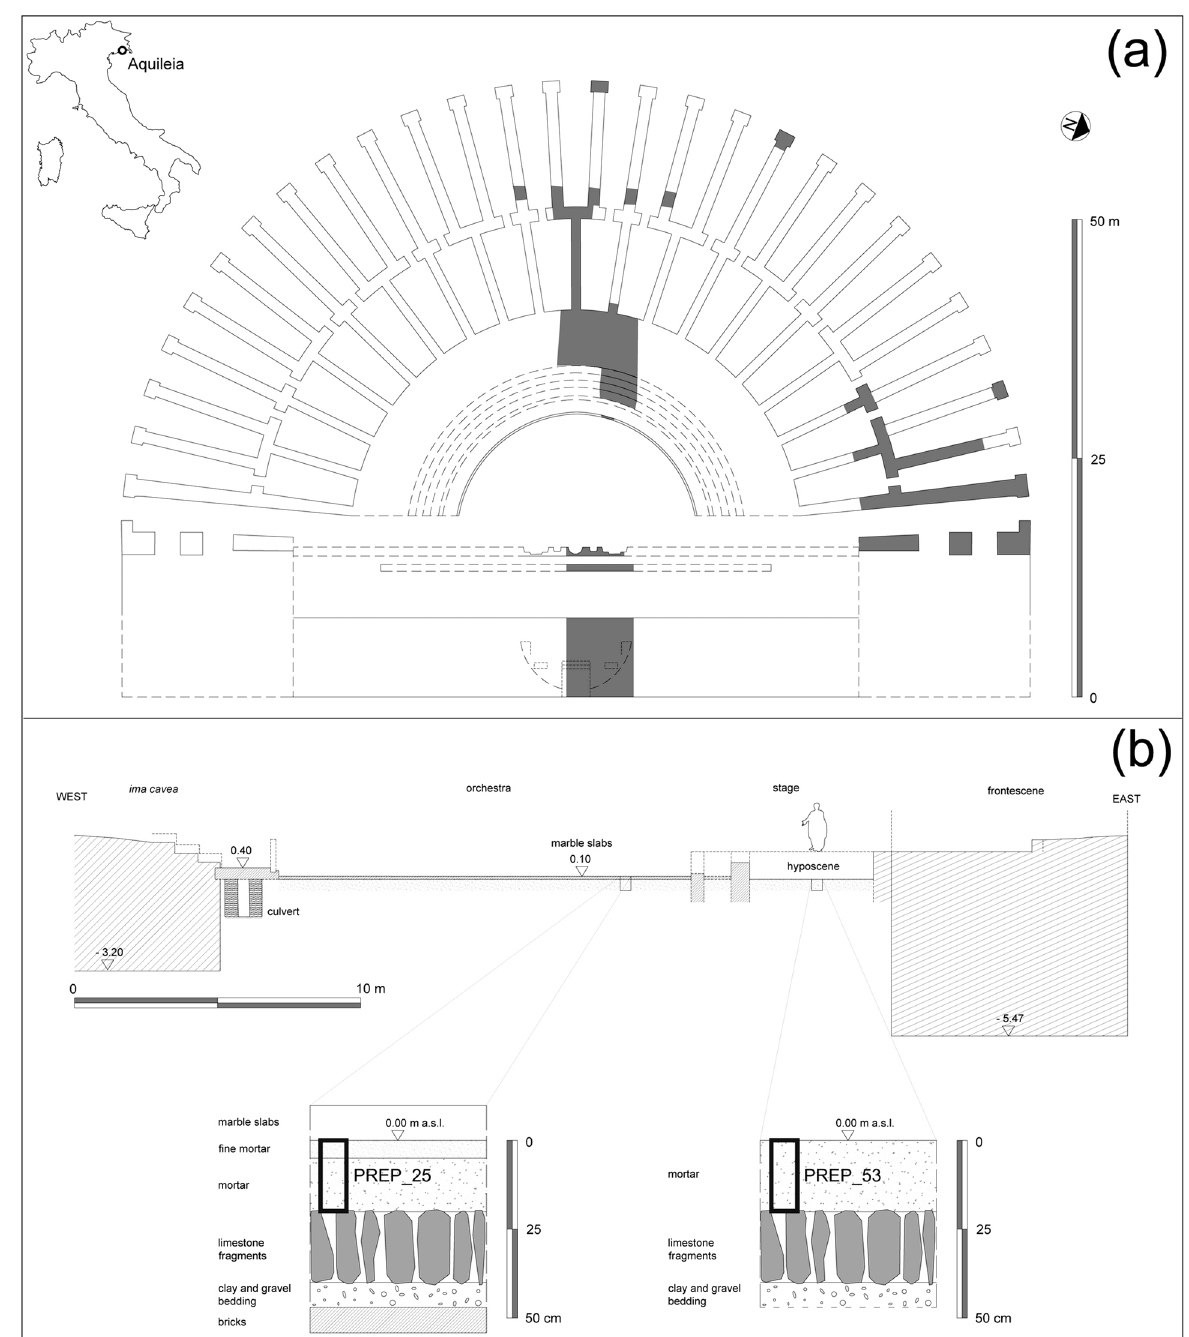
Figure 1. The Roman theatre in Aquileia. ( a ) Reconstructive plan of the building with indication of the excavated sectors (in dark grey); ( b ) Reconstructive cross section of the theatre, from the ima cavea to the scaenae frons wall, with stratigraphic sketches of the floor preparations of the orchestra and hyposcaenium